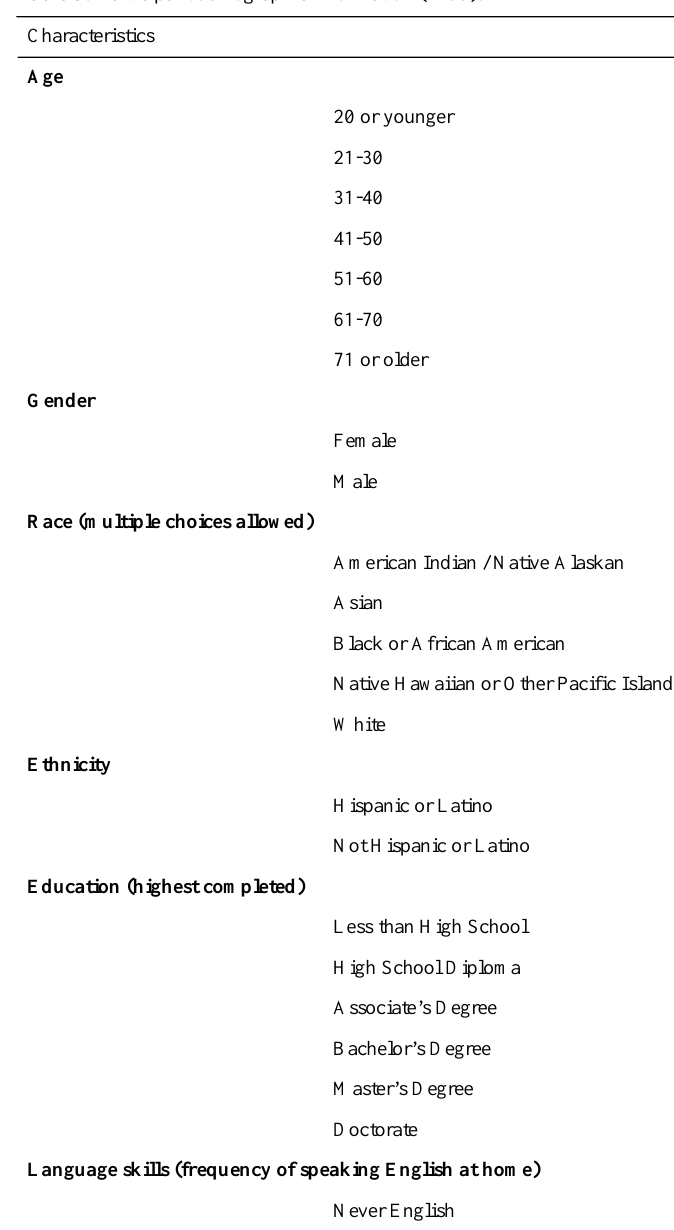
Table 3. Participant demographic information